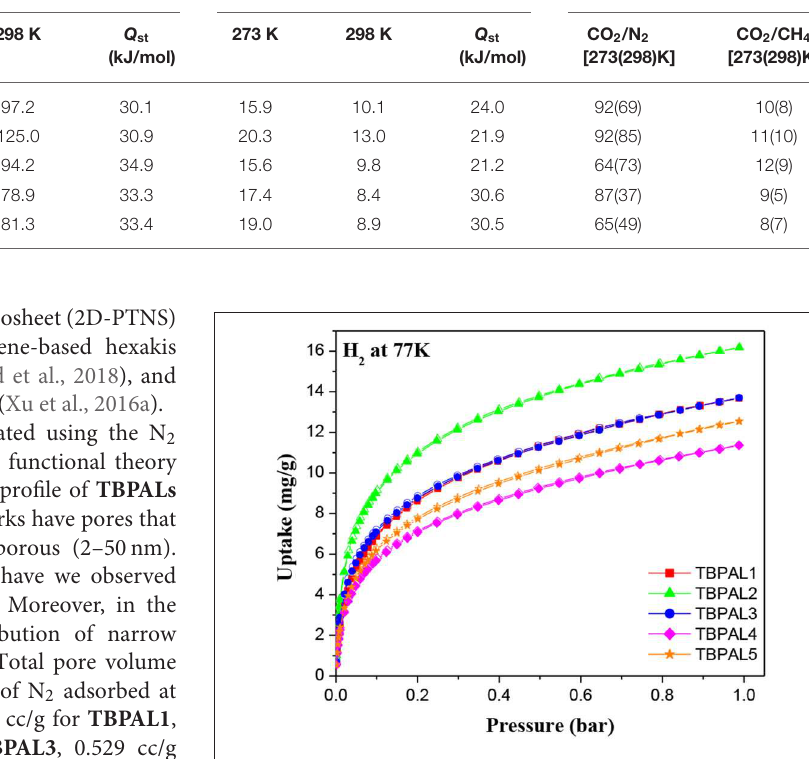
TABLE 2 | H 2 , CO 2 , and CH 4 uptakes, isosteric heats of adsorption ( Q st ) for TBPAL1–5 and CO 2 /N 2 and CO 2 /CH 4 selectivity. Polymers H 2 at 1 bar (mg/g)